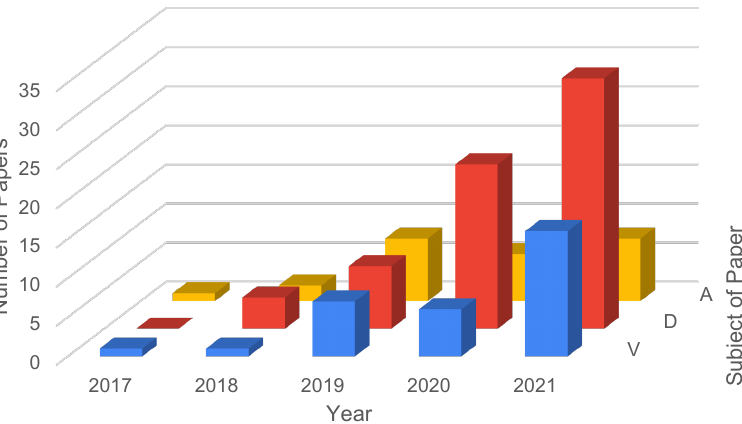
Figure 5. Review of Abstracts—number of papers focusing on vulnerabilities, attacks and